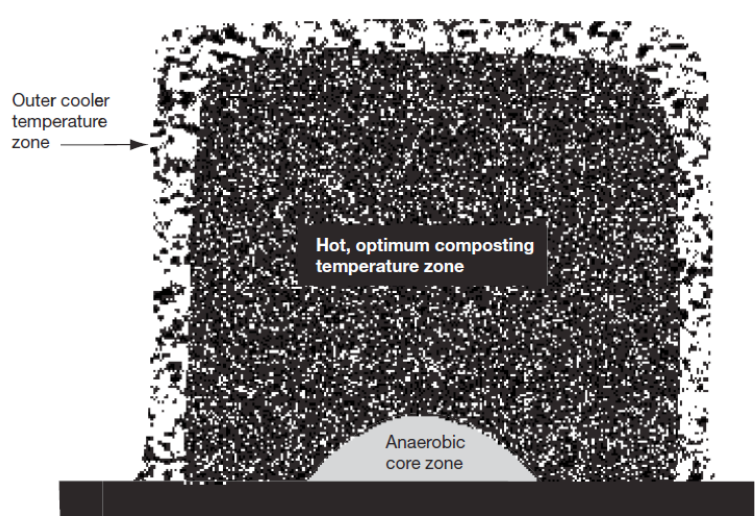
Figure 1: Pattern of compost zones used in an outdoor composting process outdoor (Beyer